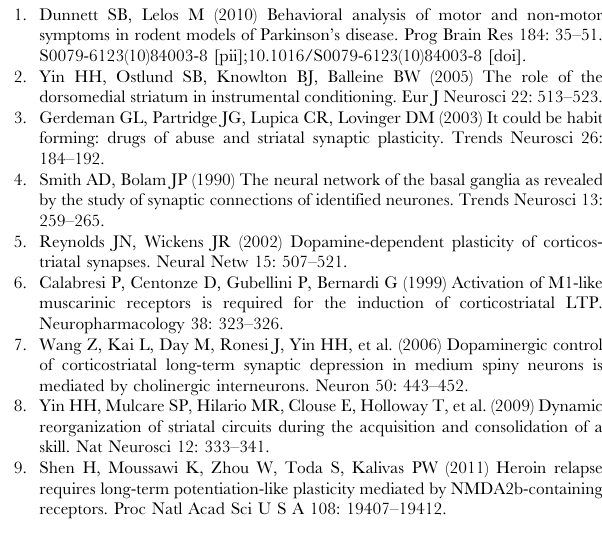
Figure S2 Results are robust to variation in parameters for both DSI and synaptic plasticity stimuli. (A) Robustness of DSI. The enhancement in 2AG by mGluR activation is quantified as the slope of the 2AG increase versus mGluR concentration for each depolarization duration. 12 parameter variations are illustrated along with the default parameters and experiment results. (B) Additional parameter variations demonstrate the robustness of the enhanced ratio of PKC to 2AG for theta burst as compared to 20 Hz. For both (A) and (B), the following parameter variations were used: Decay: 2AG decay rate is 50% of control; LowGap: decreased rate of G a qGTP hydrolysis; PSD: molecules located in the spine head are added to PSD region. SpinePLC/SpPLC: redistributed PLC, PIP 2 and mGluR into spine to make local concentration the same as in dendrite submembrane; SpineDgl/ SpDgl: increased PLC, PIP 2 , mGluR and DAG lipase into spine to make local concentration the same as in dendrite submembrane; Desens 0.5: mGluR desensitization is 50% of control; Desens 0.2: mGluR desensitization is 20% of control; Desens 4 6 : mGluR desensitization is 400% of control, and also G protein is , 3 6 of control; Dagl A: affinity of Dag Lipase for calcium is 50% of control; Dagl B: affinity of Dag Lipase for calcium is 200% of control; Dagl C: the affinity of Dag Lipase for Dag is 50% of control; Dagl D: the affinity of Dag Lipase for Dag is 200% of control. (PNG) Figure S3 DAG production is enhanced by G a qGTP, but high values of DAG saturate DAG Lipase. (A) G a qGTP increases linearly with mGluR activation (at t=0s), with no effect of calcium (at t=2s). (B–D) DAG production is enhanced by G a qGTP for all durations of depolarization. (E–F) The increased DAG production is translated into increased 2AG for 1s depolarization (E), but less so for 5 s depolarization since DAG saturates the DAG lipase (i.e., the DAG bound DAG lipase approaches the total 1.7 m M of DAG lipase) with low concentrations of DHPG (F).